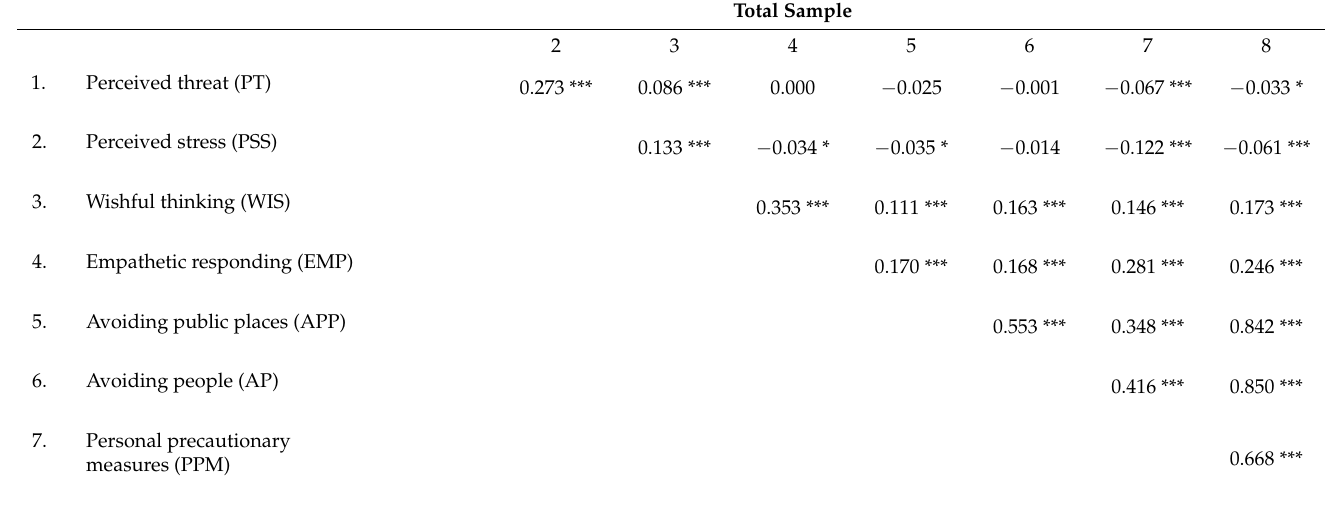
Table 3. Correlation matrix between perceived threat, perceived stress, coping responses and COVID-19 infection control practices in all